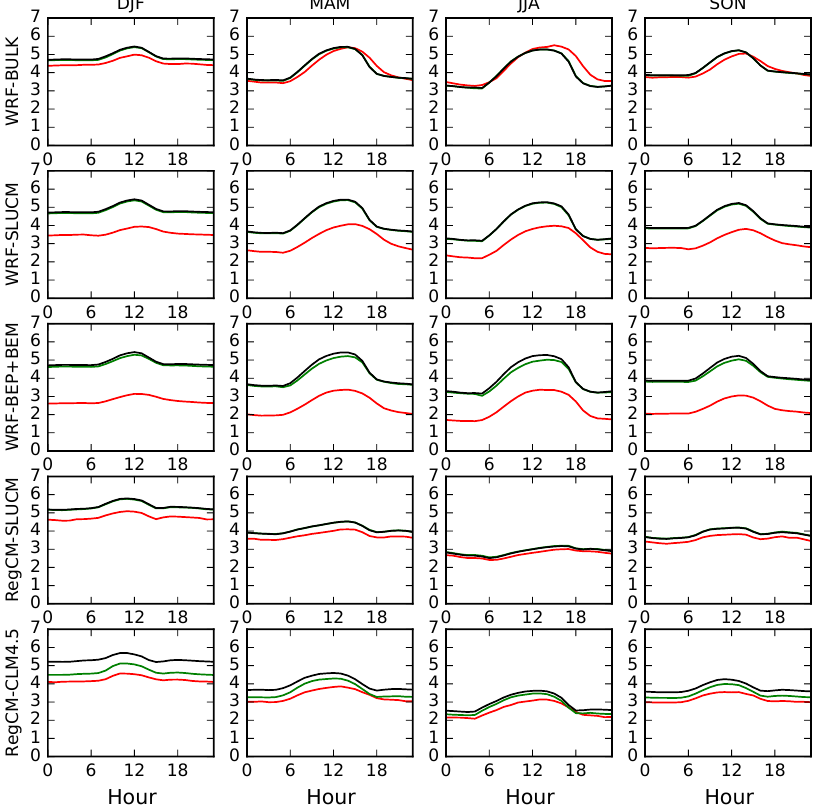
Figure 11. Averaged horizontal wind speed daily cycles (ms − 1 ) in the Prague city centre (red), in its surroundings (green) and as simulated with the urban surface removed